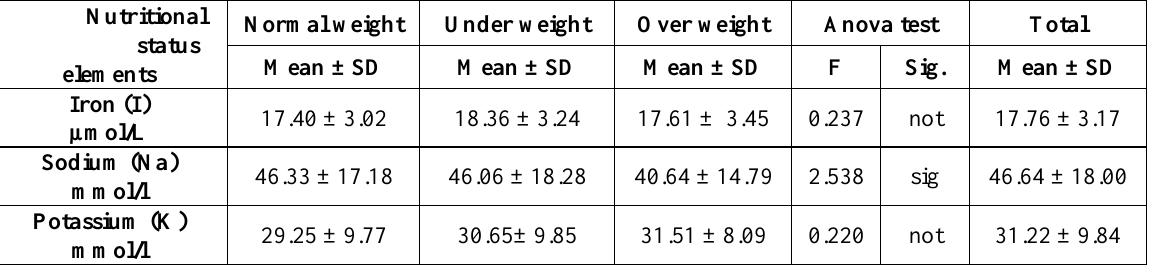
SD=Stander deviation, Significance level at P < 0.05 Table 4: Correlations between (Iron, Sodium and Potassium) in Saliva and BMI in Each Nutritional